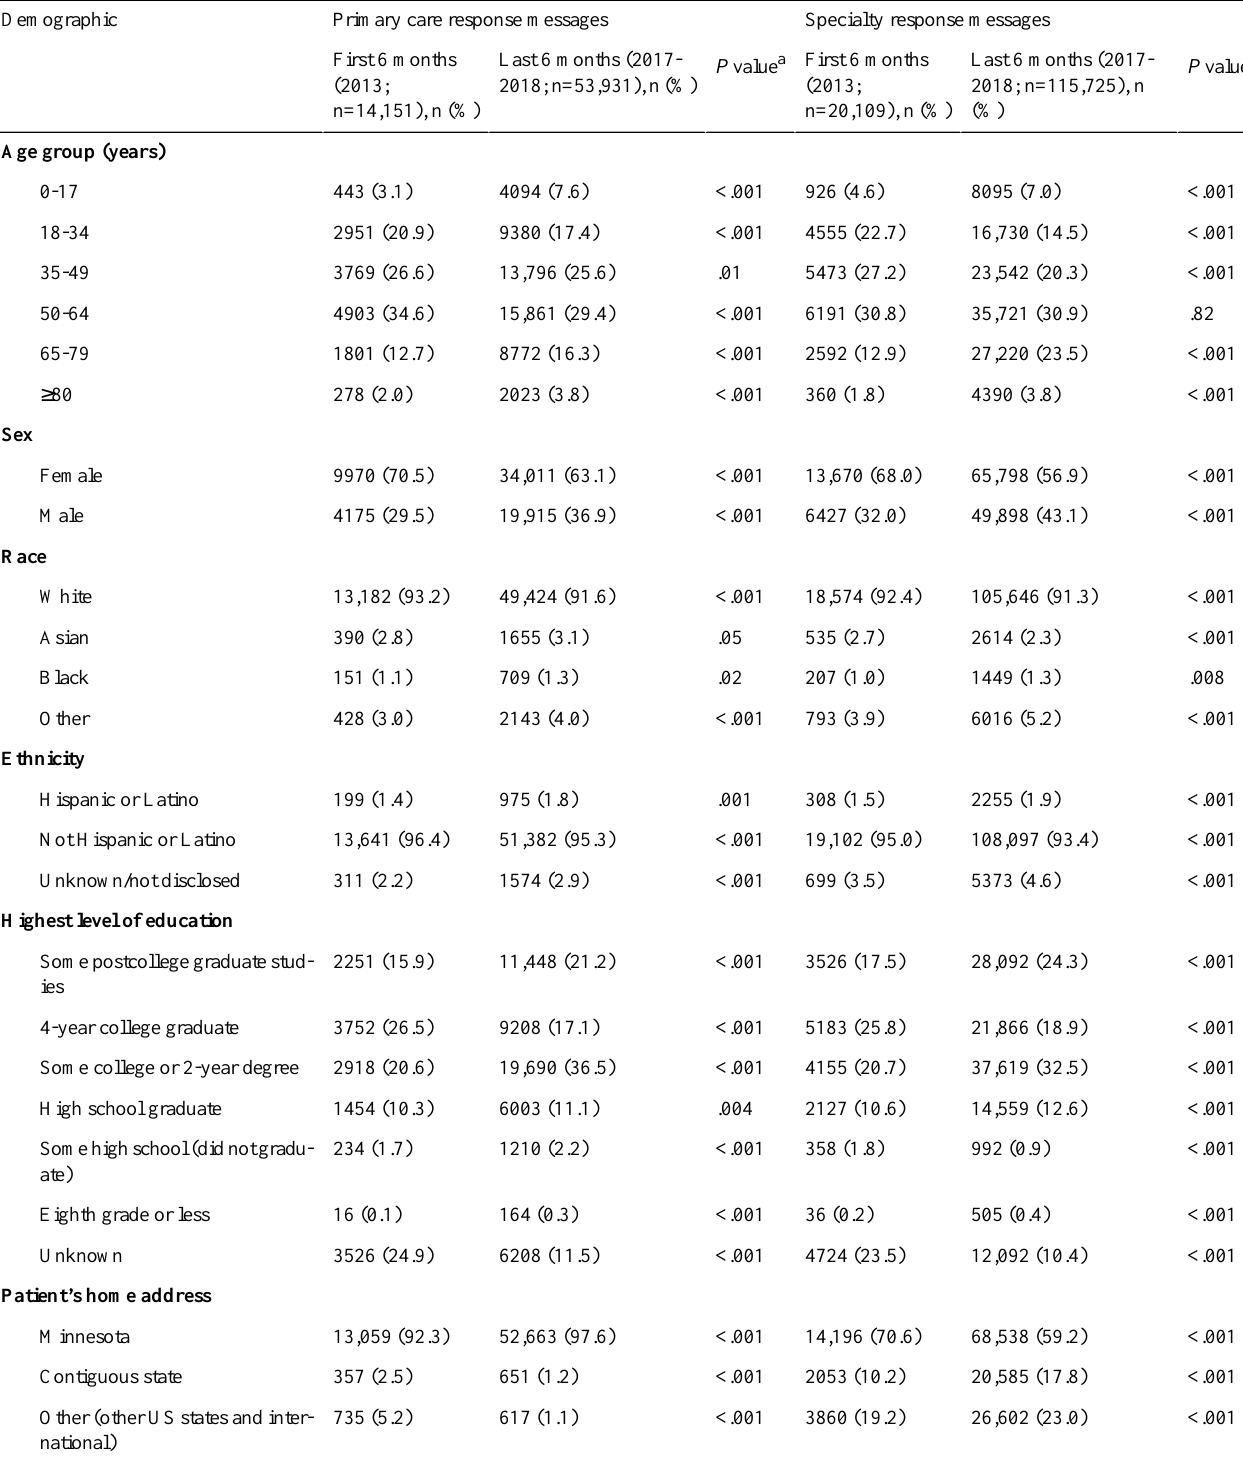
Table 1. Demographic comparisons of the patients who initiated messages and had provider responses from 2013 to 2018 by provider type (primary care or